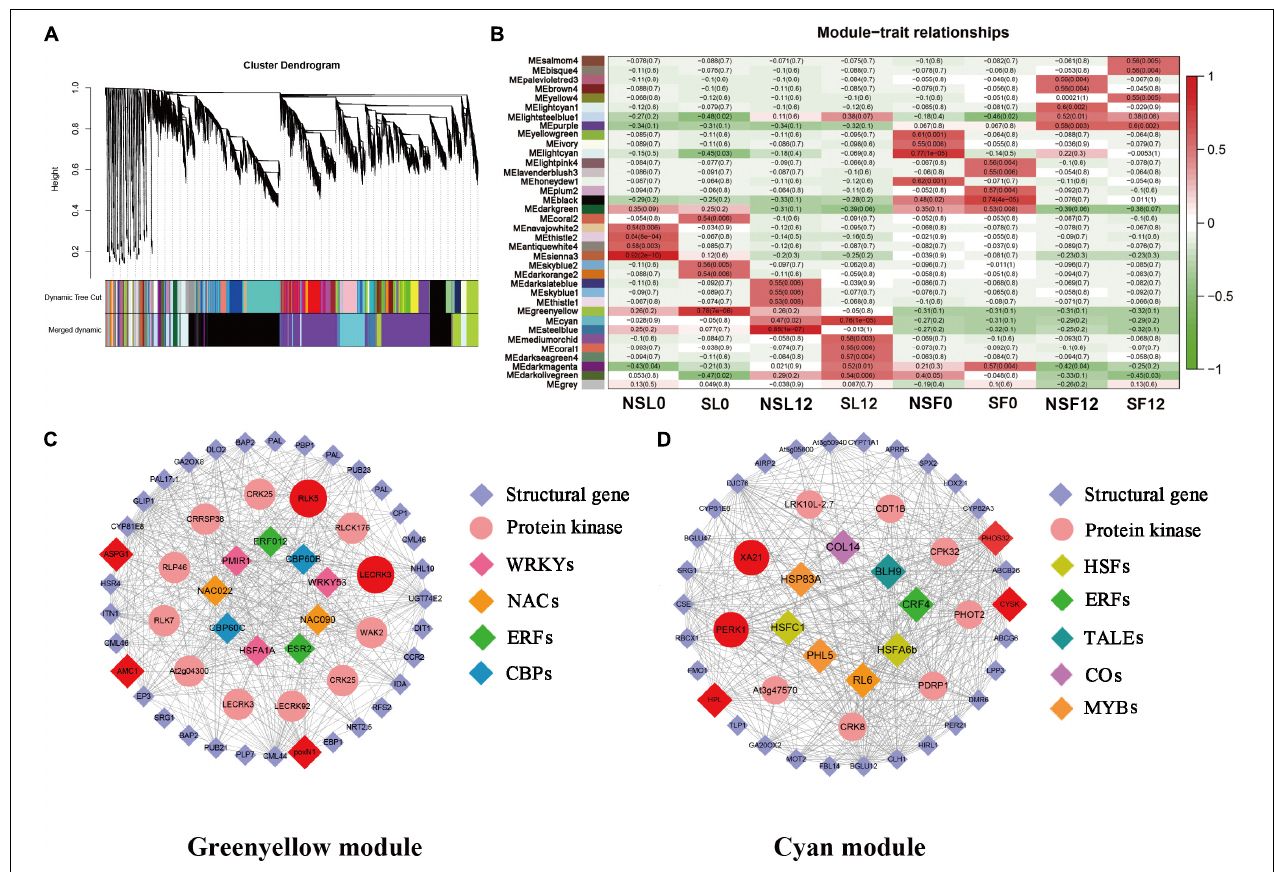
FIGURE 4 | Weighted gene co-expression network analysis (WGCNA)-identified gene networks and hub genes involved in cucumber stress response after S fumigation. (A) Notably, 36 modules with co-expressed genes were hierarchically clustered. Each leaflet in the tree corresponds to an individual gene. (B) Module-trait associations based on Pearson’s correlation. The colors from green to red represent r 2 values from − 1 to 1. (C) The gene network for the green-yellow module positively correlated with SL0 (the young leaves with S fumigation) ( r 2 = 0.78 and P = 7.00E-06). (D) The gene network for the cyan module positively correlated with SL12 (the mature leaves with S fumigation) ( r 2 = 0.76 and P = 1.00E-05). In each network, hub genes are highlighted with enlarged spots and marked red. WRKYs, WRKY transcription factors; NAC, NAC transcription factors; ERFs, ERF transcription factors; CBPs, CBP transcription factors; HSFs, HSF transcription factors; ERFs, ERF transcription factors; TALEs, TALE transcription factors; COs, CO transcription factors; MYBs, MYB transcription